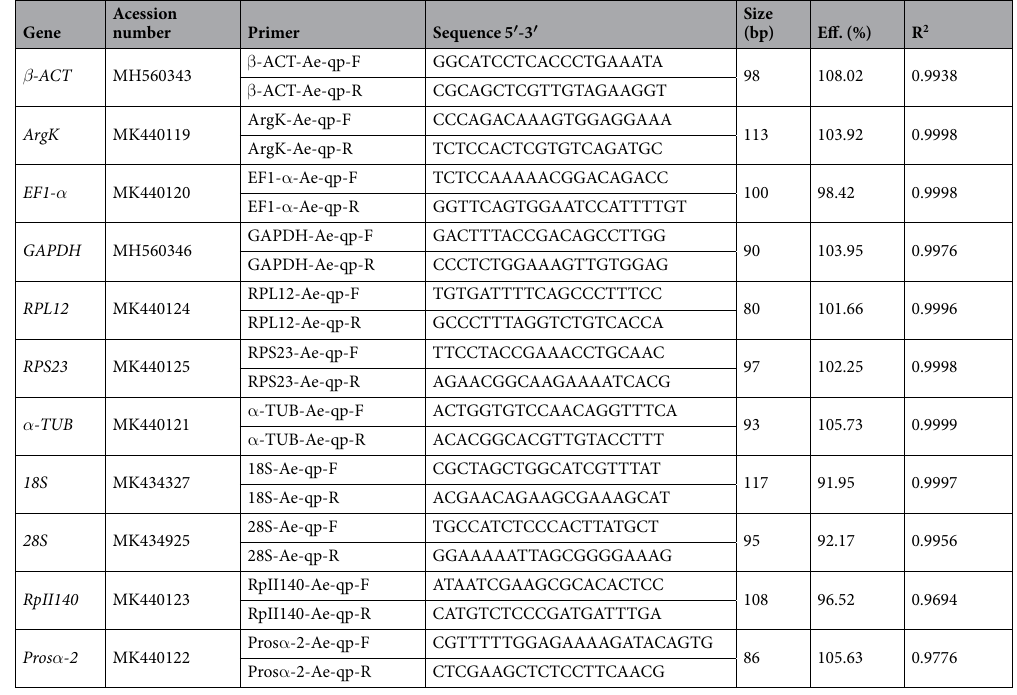
Table 1. Primers for the candidate reference genes and RNAi target genes used in the RT-qPCR